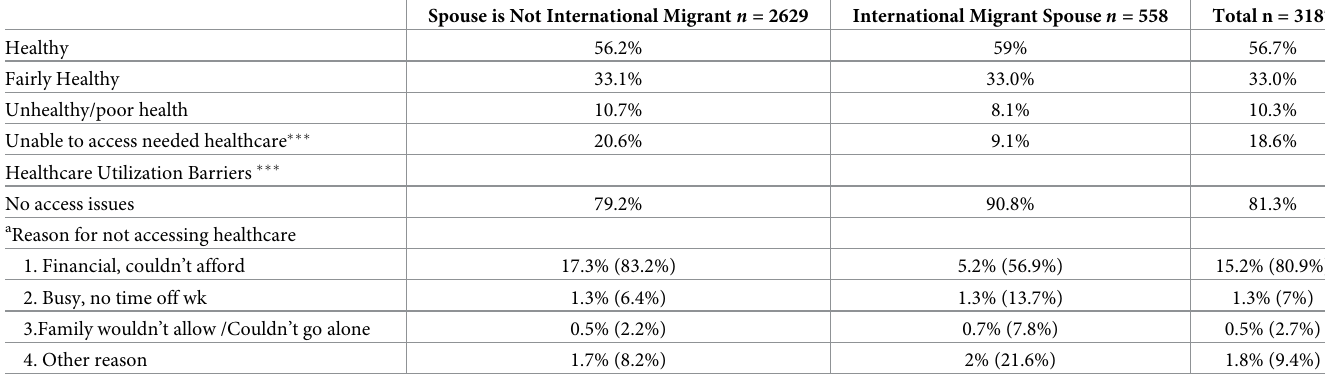
Table 2. Description of respondents healthcare access by spousal migration